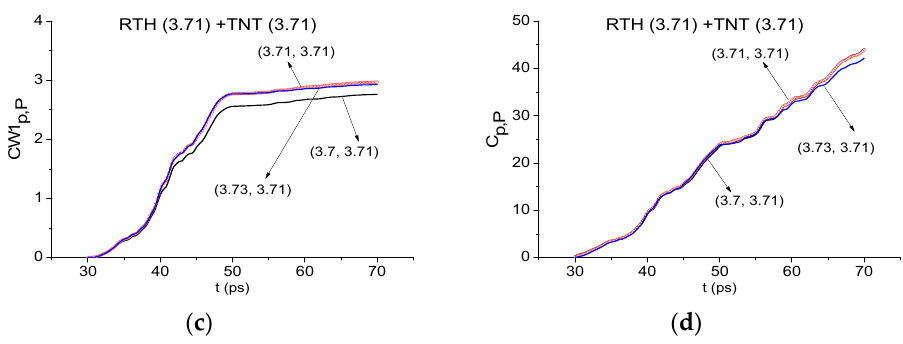
Figure 16. ICCs CW 1 p , P (a,c), C p , P ( b,d ) detecting the frequencies ν = 3.0 THz ( a,b ) and 3.71 THz ( c,d ) as RDX and TNT absorption frequencies, respectively, in the RTH first sub-pulse spectrum. In Figure 17 the frequencies ν = 2.88 THz and 2.74 THz (Figure 8) are detected also as the absorption frequencies of HMX (a), (b) and PETN (c), (d) in the RTH and RTP first sub-pulse spectra. The minimal FDRs are ν = [2.87, 2.92] THz (a), (b) and [2.72, 2.75] THz (c), (d), respectively.